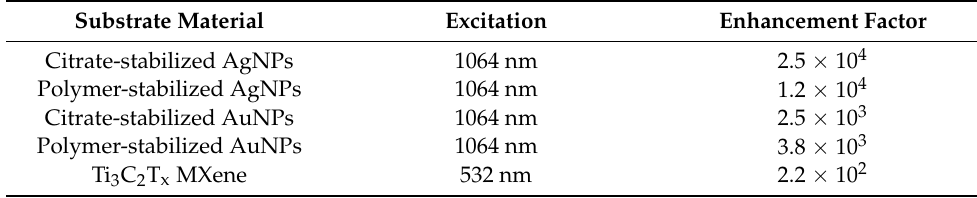
Table 4. Comparison of enhancement factors for salicylic acid achieved with different